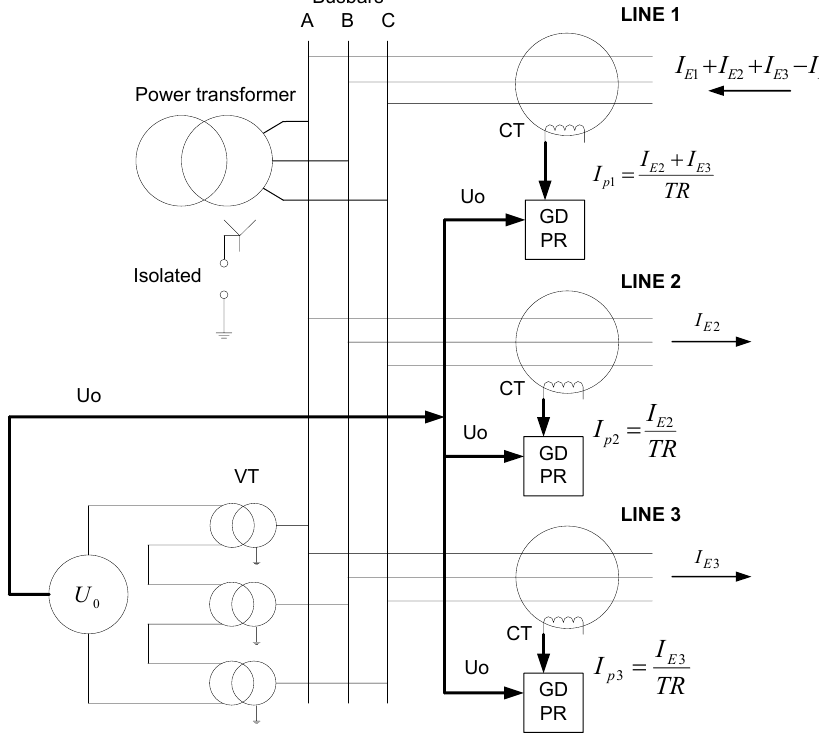
Figure 1. Residual current distribution in an underground neutral undergrounded system with ground fault at F in phase “ c ” of Line